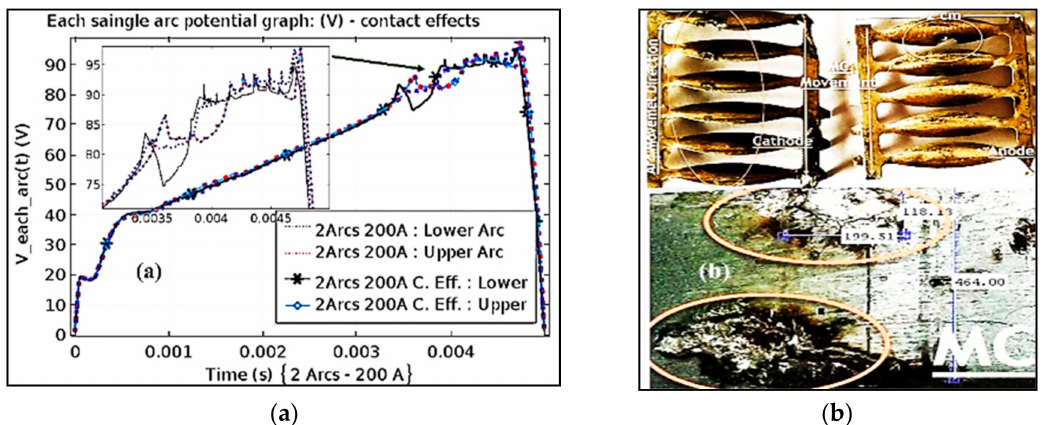
Figure 12. ( a ) Ablation on fixed and moving contacts (MC in figures means moving contact) and ( b ) Two 200 A peak arcs with(out) thermionic emission modeling.